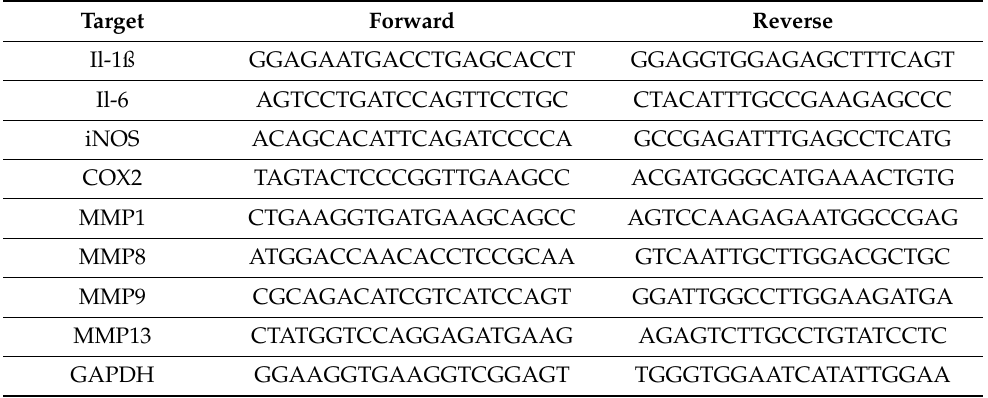
Table 2. qRT-PCR primer